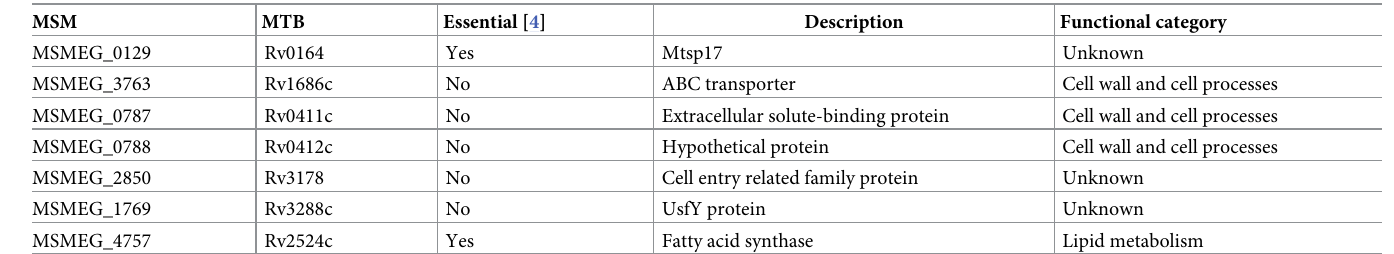
Table 2. DEGs common to all three of the pair-wise comparisons.